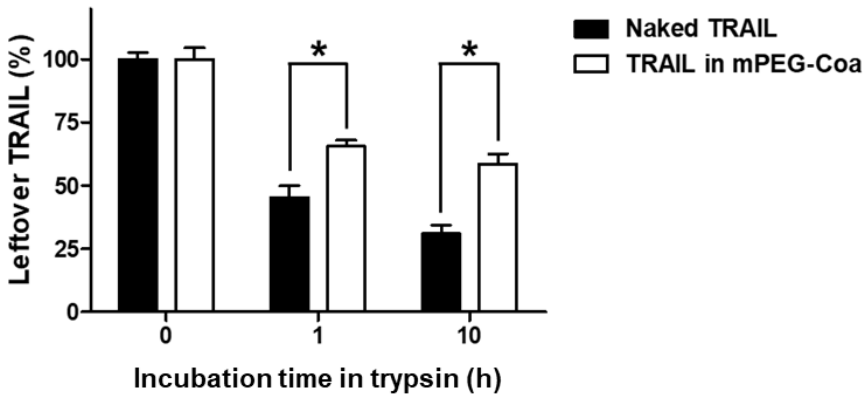
Figure 4. Cargo TRAIL protection ability of mPEG-Coa against trypsin, indicated by the remaining TRAIL amounts. (*) indicates that the two experimental groups are statistically different to each other.